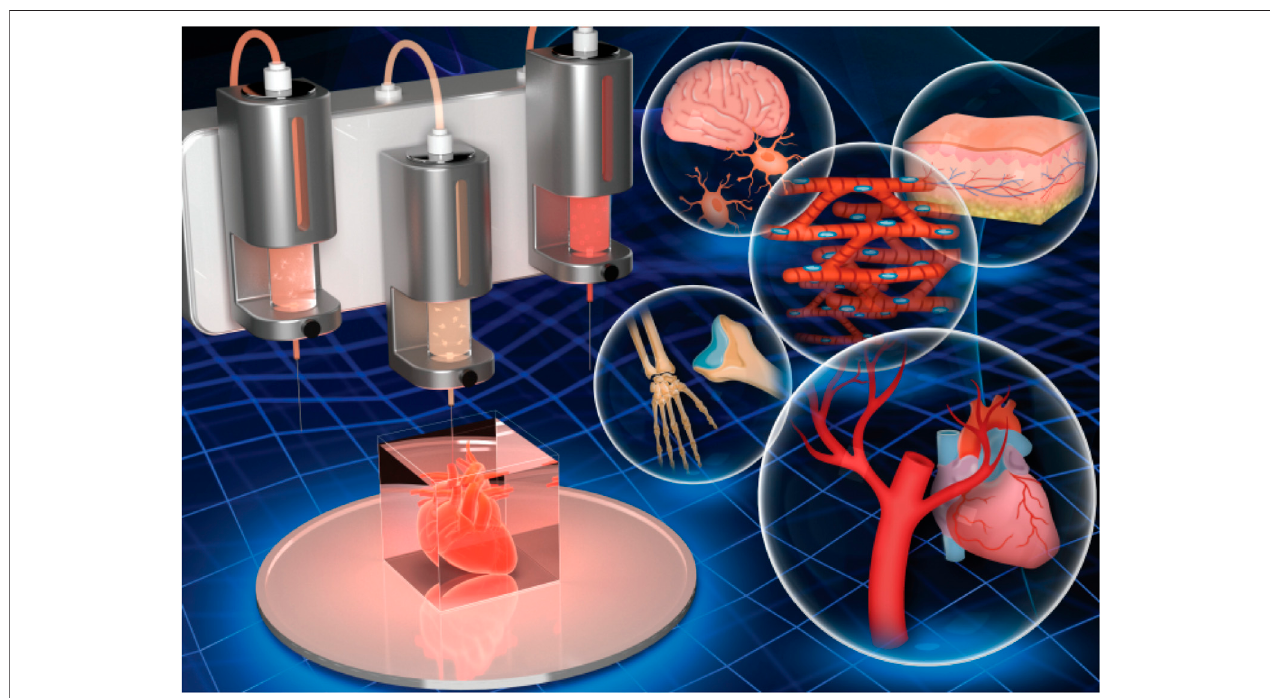
FIGURE1| 3Dbioprintingofhydrogelconstructsfortissueregeneration.ReproducedfromAskarietal.,(2021)withpermissionfromCopyright2021RoyalSociety of Chemistry.